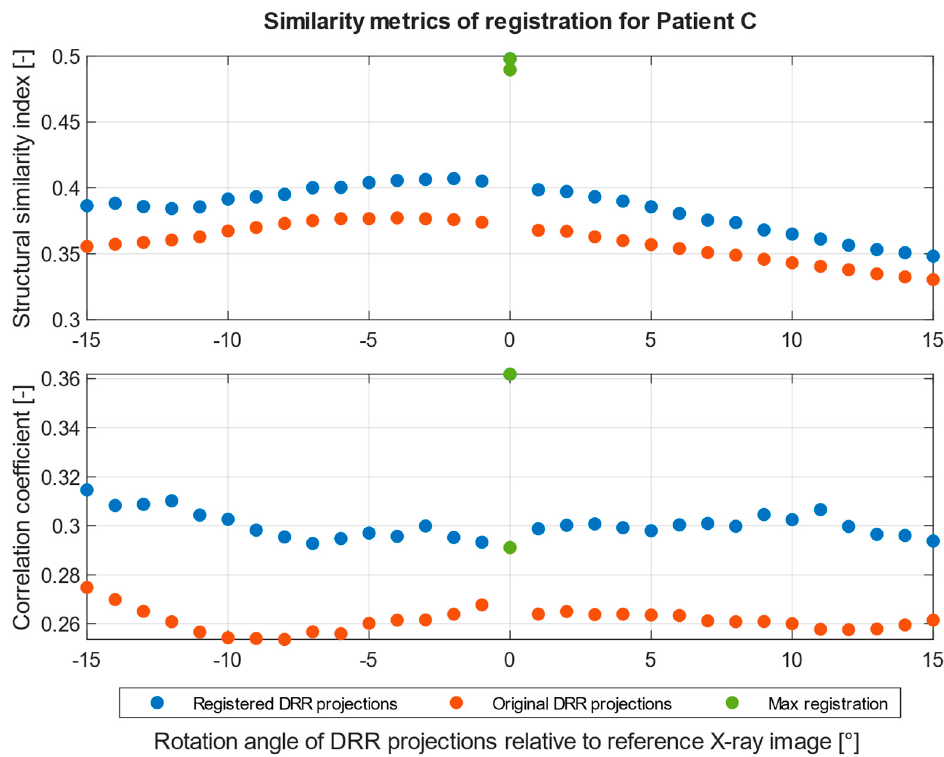
Figure 11. Similarity metrics of image registration of 30° angel range for Patient C. DRR projection with the highest similarity marked as green.